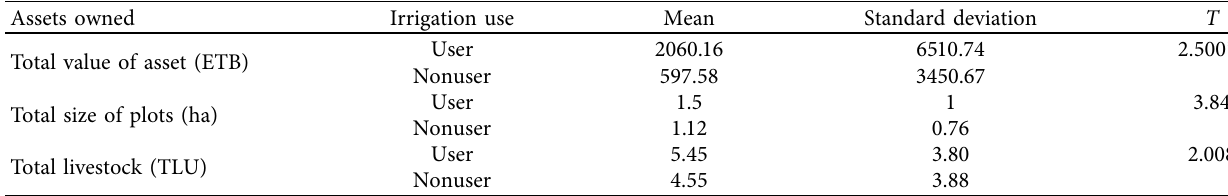
Table 7: Endowment of assets of households with and without irrigation.